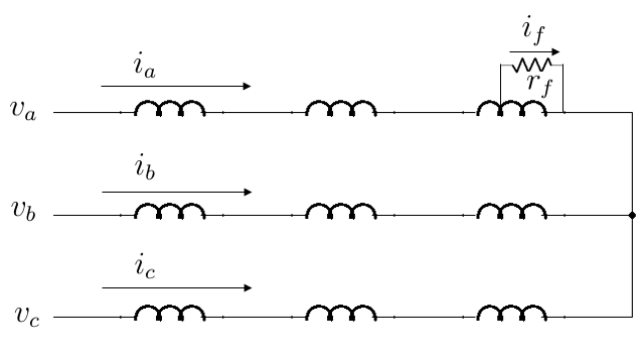
Figure 1. An interturn short-circuit fault in phase a of stator